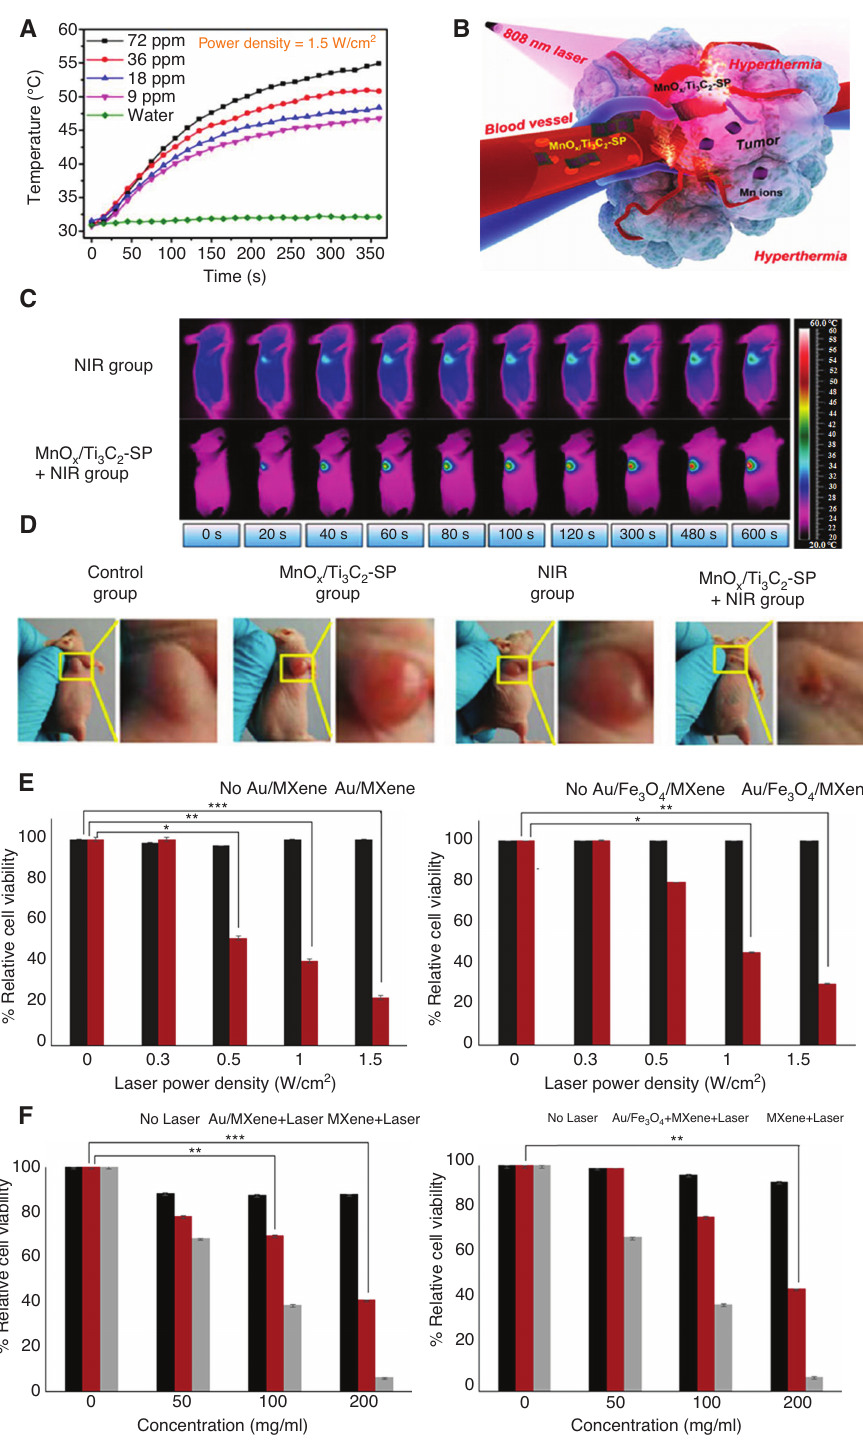
C -based PTT of 3 2